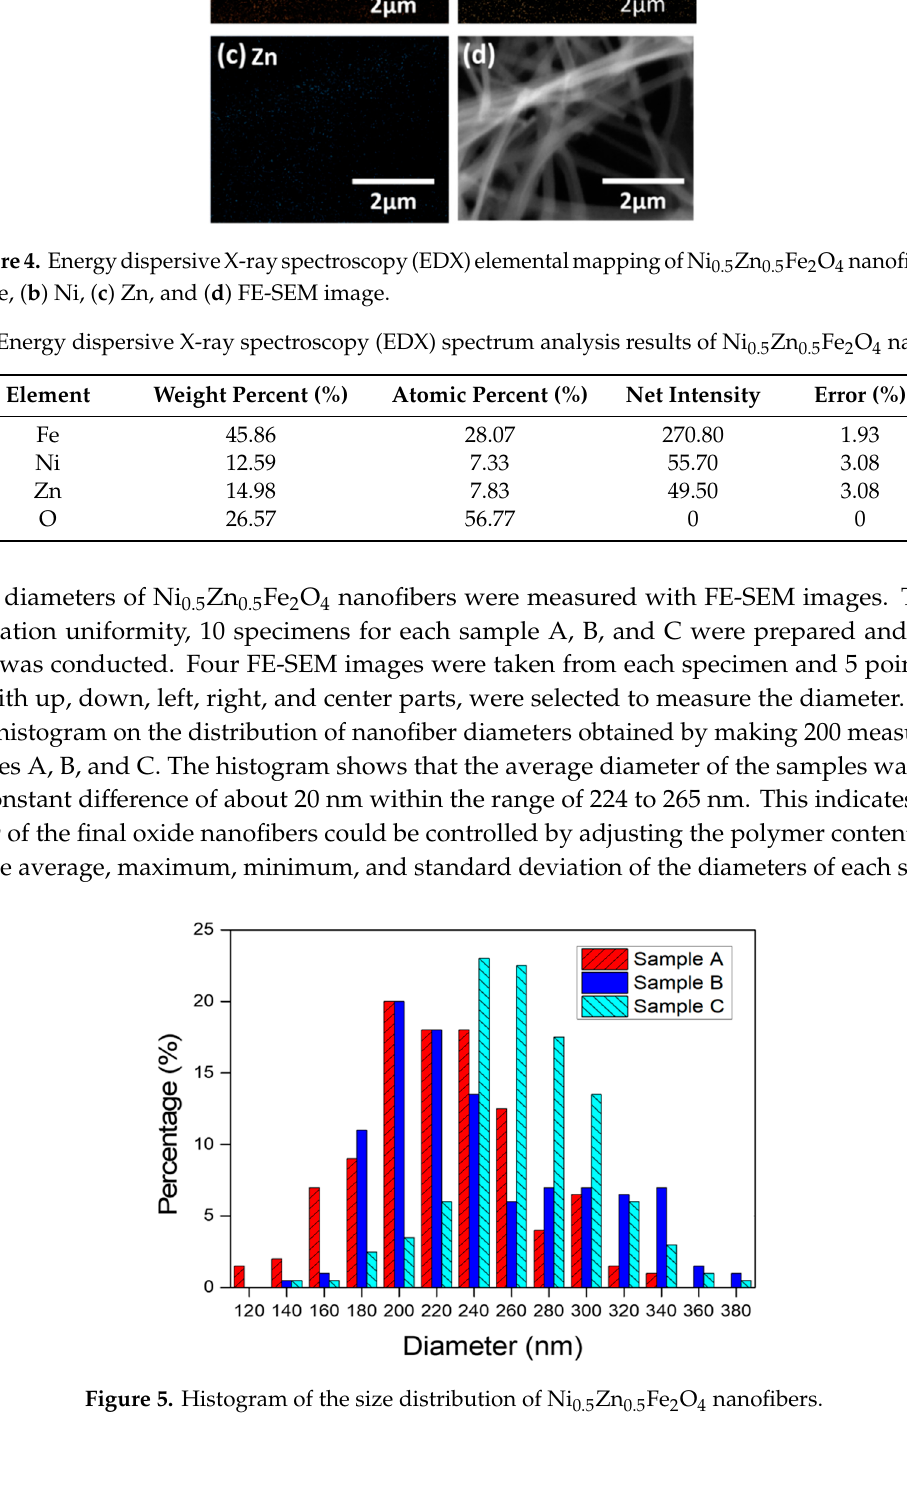
Figure 5. Histogram of the size distribution of Ni 0.5 Zn 0.5 Fe 2 O 4 nanofibers.